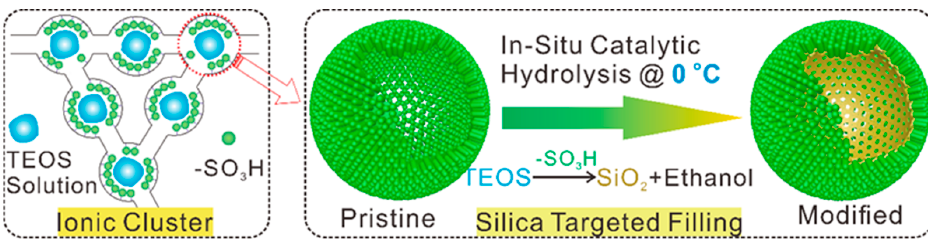
Figure 7. Schematic of the in situ, controllable sol–gel reaction of silica in the ionic cluster of the Nafion [134]. Nafion